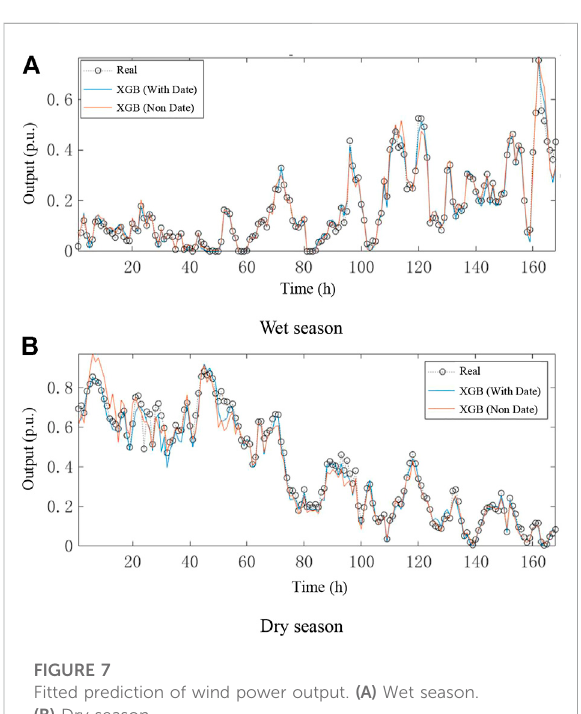
FIGURE 7 Fitted prediction of wind power output. (A) Wet